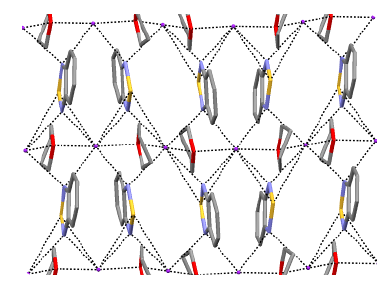
Figure 7. XRD structure of RA salt 69